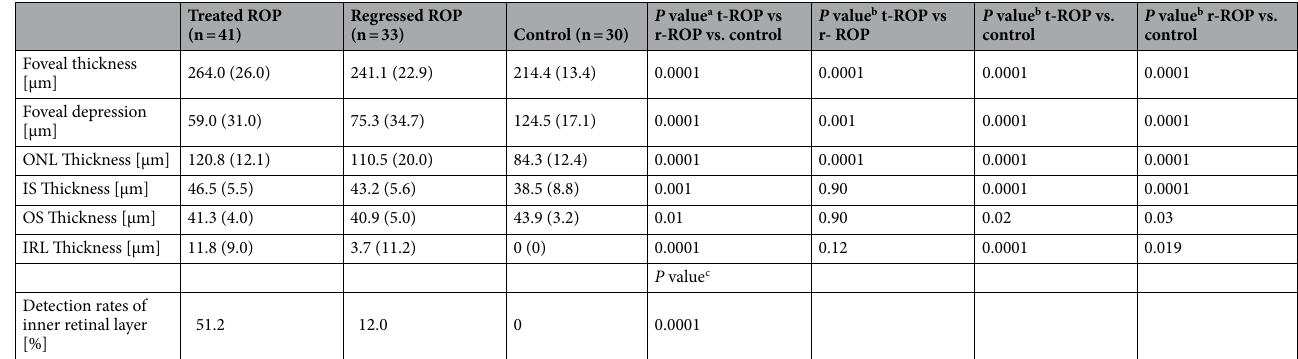
Table 2. Optical coherence tomography findings of the patients and controls. Data are expressed as mean (standard deviation). P value : a Analysis of variance (ANOVA) b Tukey c χ 2 -test. logMAR: logarithm of the minimum angle of resolution, ROP: retinopathy of prematurity, ONL: outer nuclear layer, IS: inner segment, OS: outer segment, IRL: inner retinal layer, t-ROP: treated ROP, r-ROP: regressed